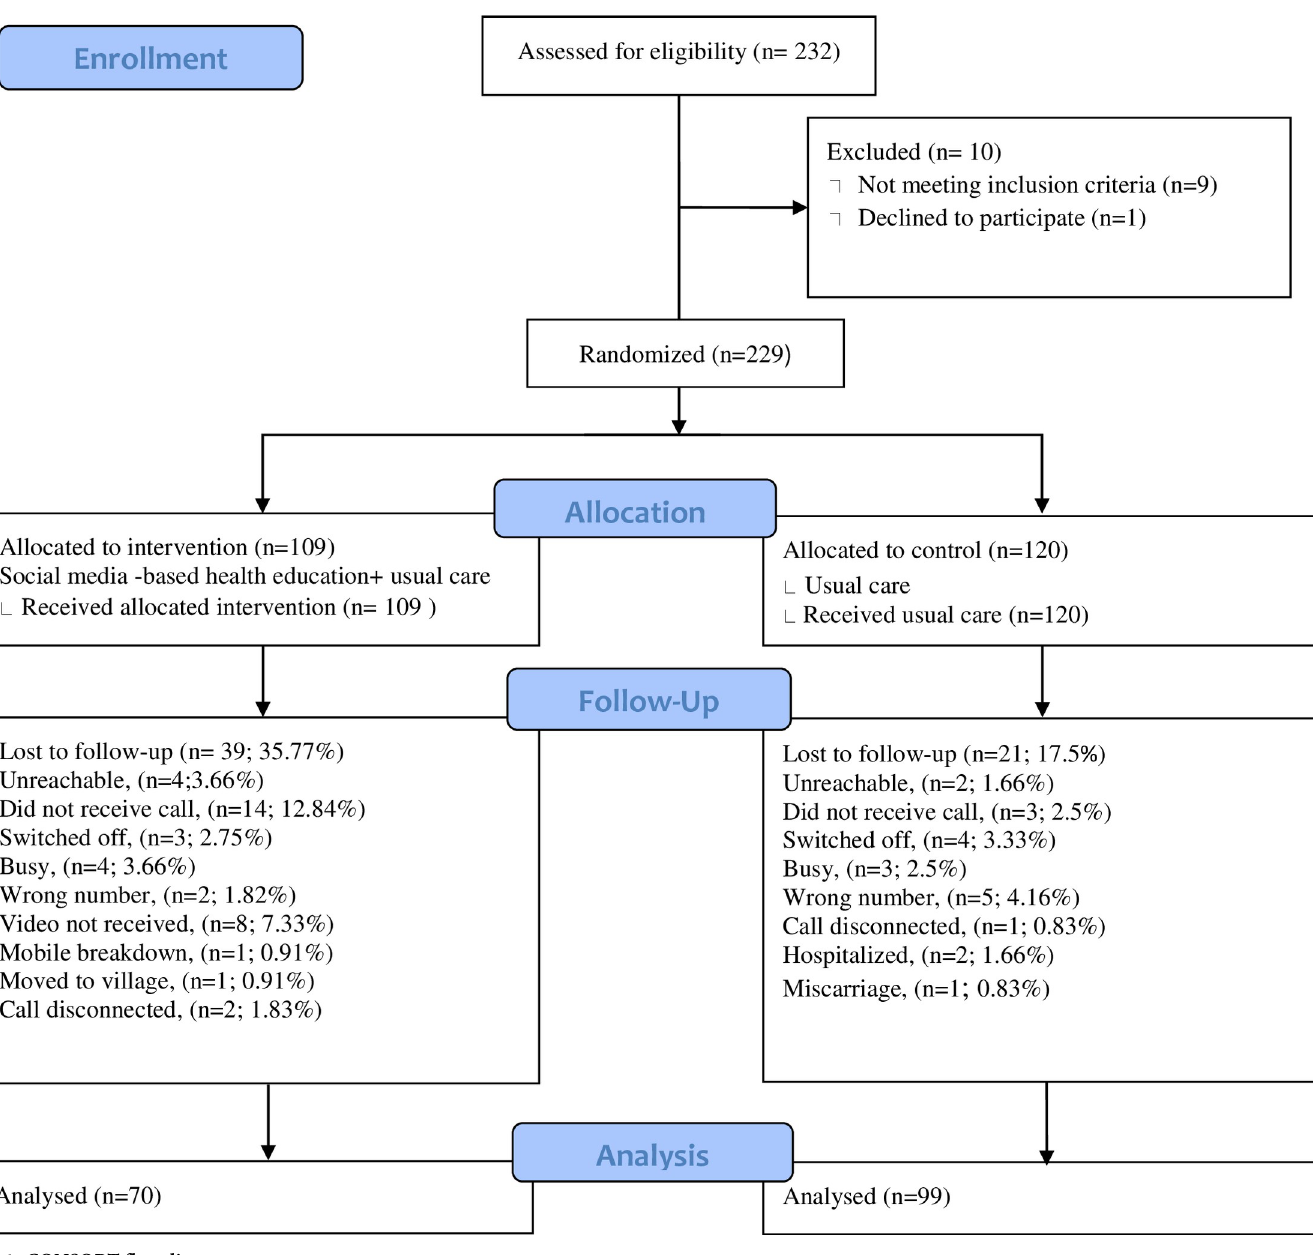
every 2 hours was the correct response for frequency of urination during postnatal period. About 9% of the respondent gave correct response for the minimum time for starting sexual intercourse was after 42 days. More than three-fourth of the participants were aware of pro- tein, carbohydrate, vitamins and high fluid intake as necessary diet for postpartum mothers. Almost all ( > 90%) participants knew minilap, pills, depo and condom as the measures for family planning. There was no difference in the maternal care attributes knowledge between the intervention and control group (Table 6).